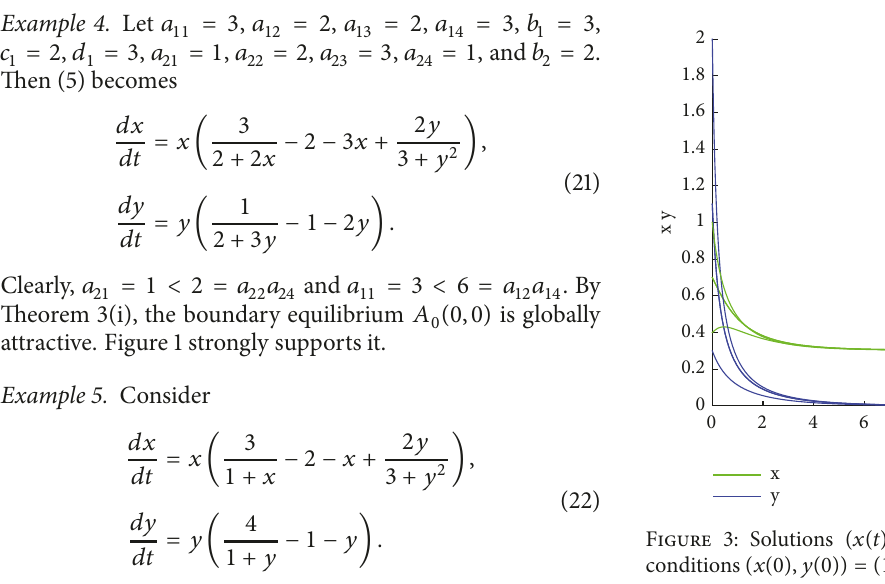
(𝑥(𝑡),𝑦(𝑡)) of system (22), with the initial conditions (𝑥(0),𝑦(0)) = (1,0.3) , (0.4, 2) , and (0.7, 1.1) .